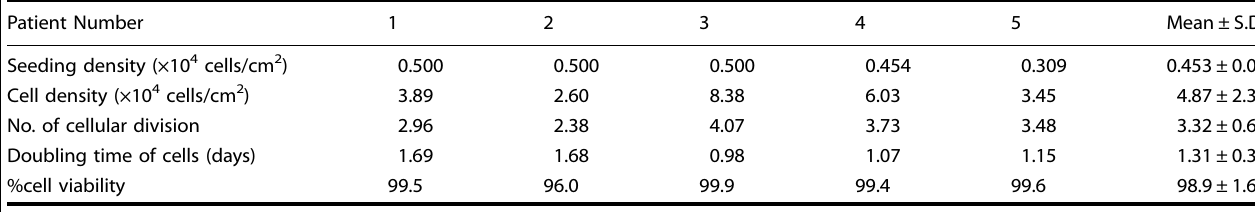
Doubling time of cells (days)